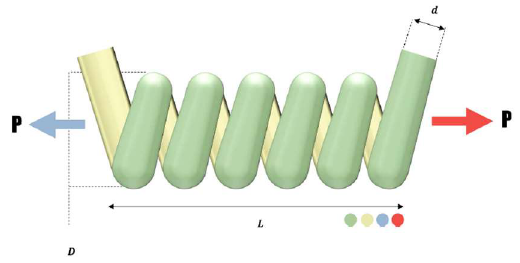
Figure 7. Tension spring problem.